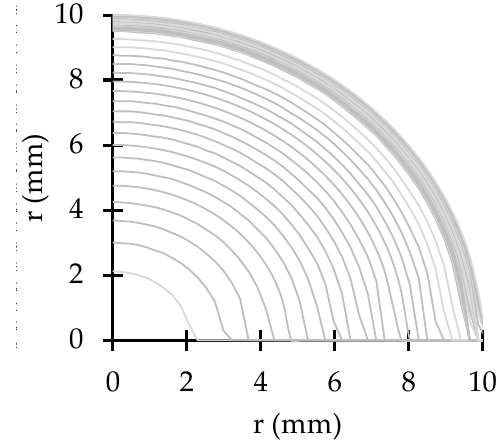
Figure 7. Radial mesh for the OEAC40 N 5% = 20.